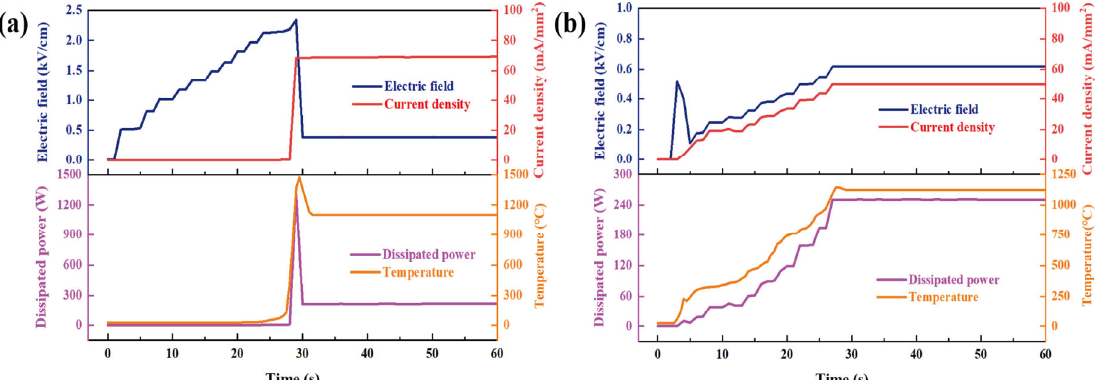
Fig. 1 Electric field, current density, dissipated power, and surface temperature as a function of time for the (a) FS-A1 and (b) FS-B1 samples during